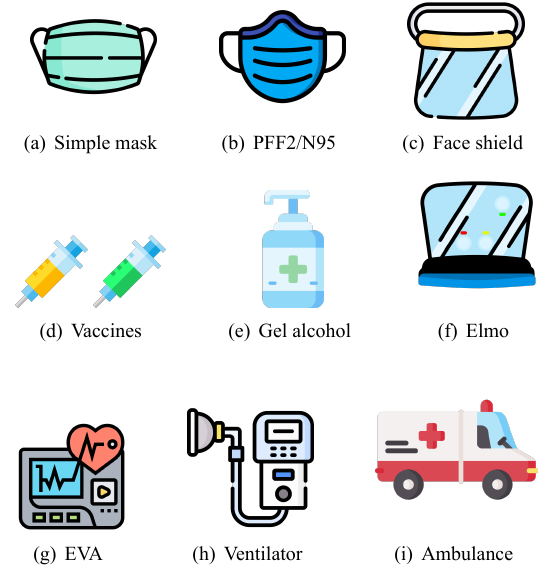
Figure 5. Collectible in-game items. Icons are from free stock images cre- ated by Eucalyp (2021), Freepik (2021), and Smashicons